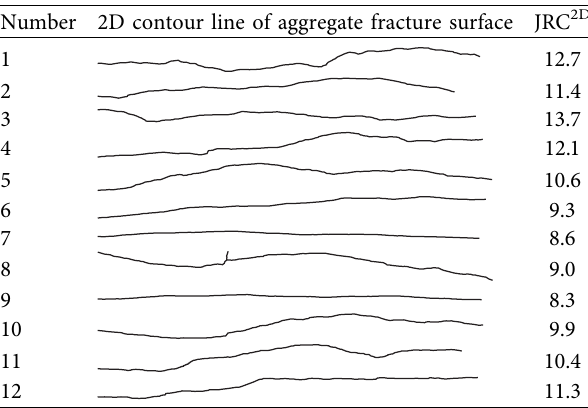
Table 6: 2D roughness of contour lines along the y